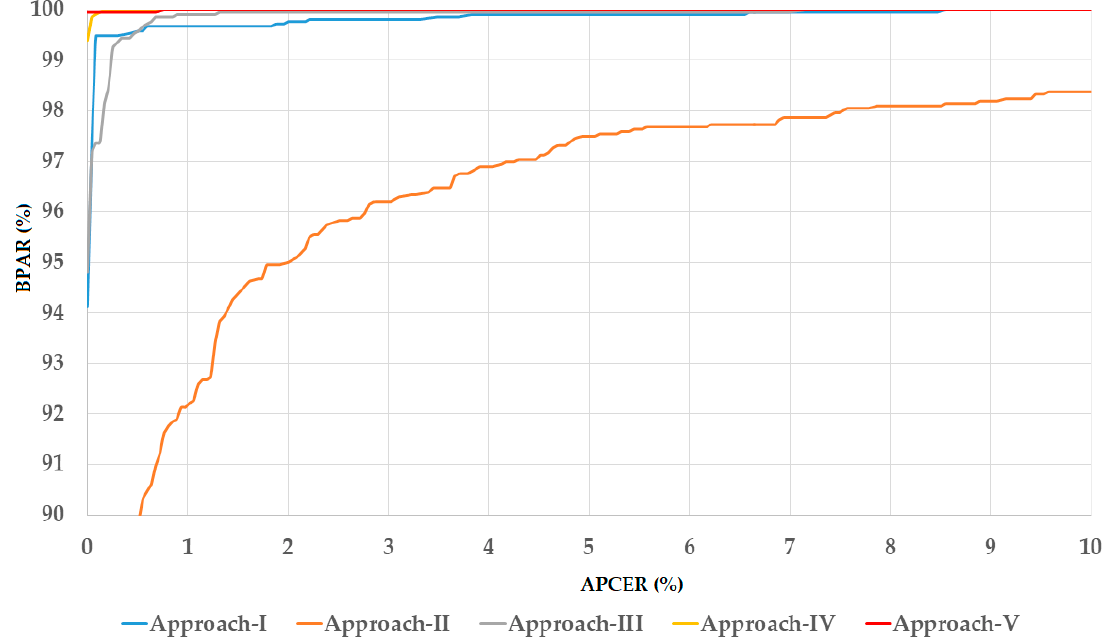
Figure 7. Detection error trade-off (DET) curves of iPAD systems according to best detection accuracy presented in Table 5b using three-channel images of fusion of gray and Retinex images for iPAD.